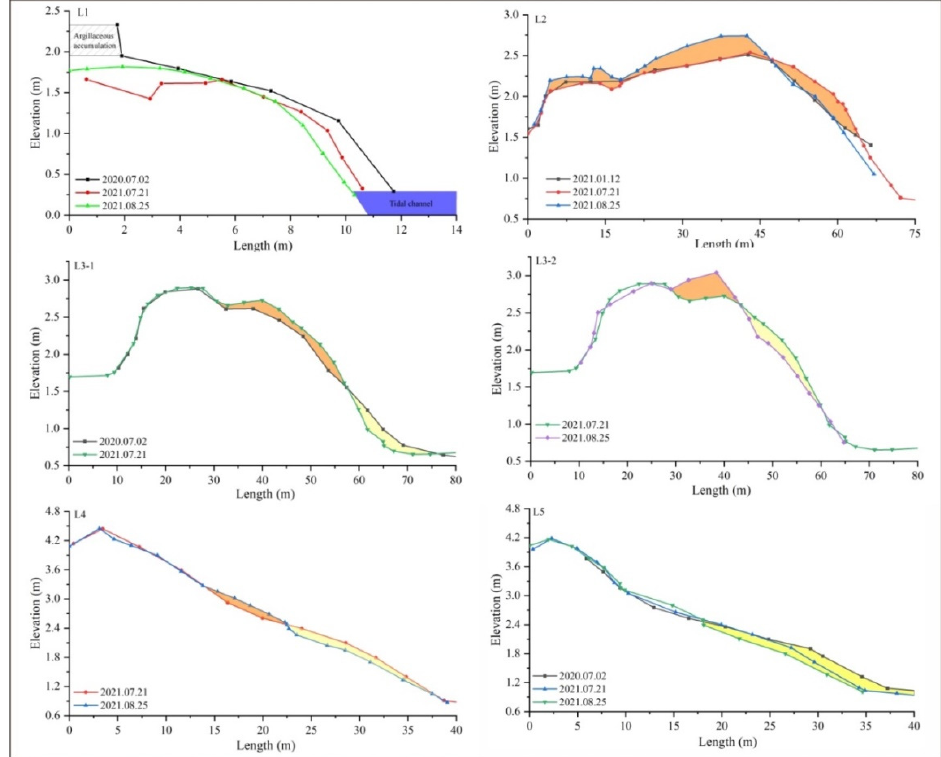
Figure 6. The results of the beach profile elevation survey with GPS-RTK. Line L1–L3 belongs to the tidal channel shelly chenier; line L4–L5 belongs to open shelly chenier. The colored fill between lines indicates the amount of erosion or accretion, where yellow stands for erosion, while orange stands for accretion. Typhoon In-fa occurred on 22–25 July 2021.